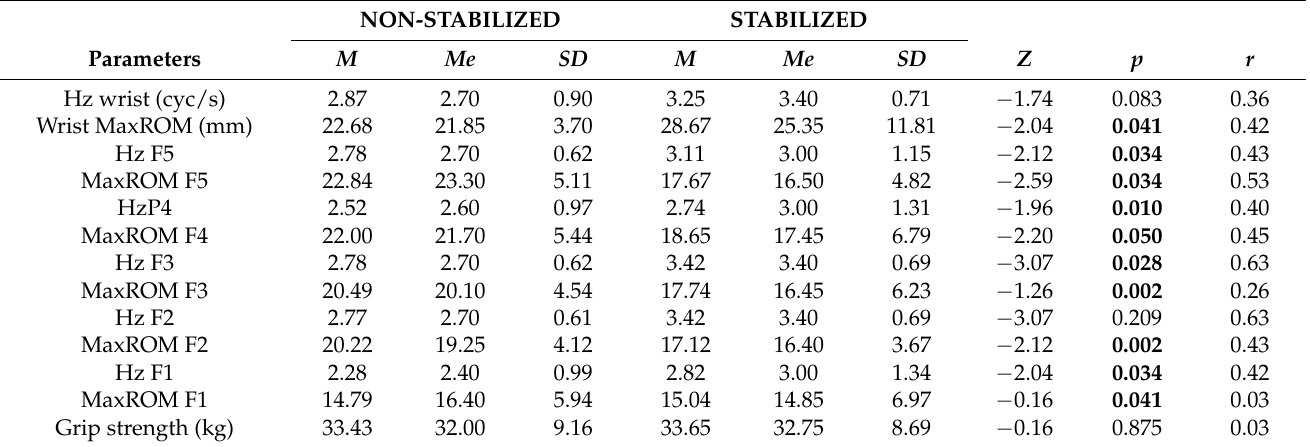
Table 9. Comparison of the results of the parameters in the unstable and stabilized position for the age group of 46–60 healthy people.